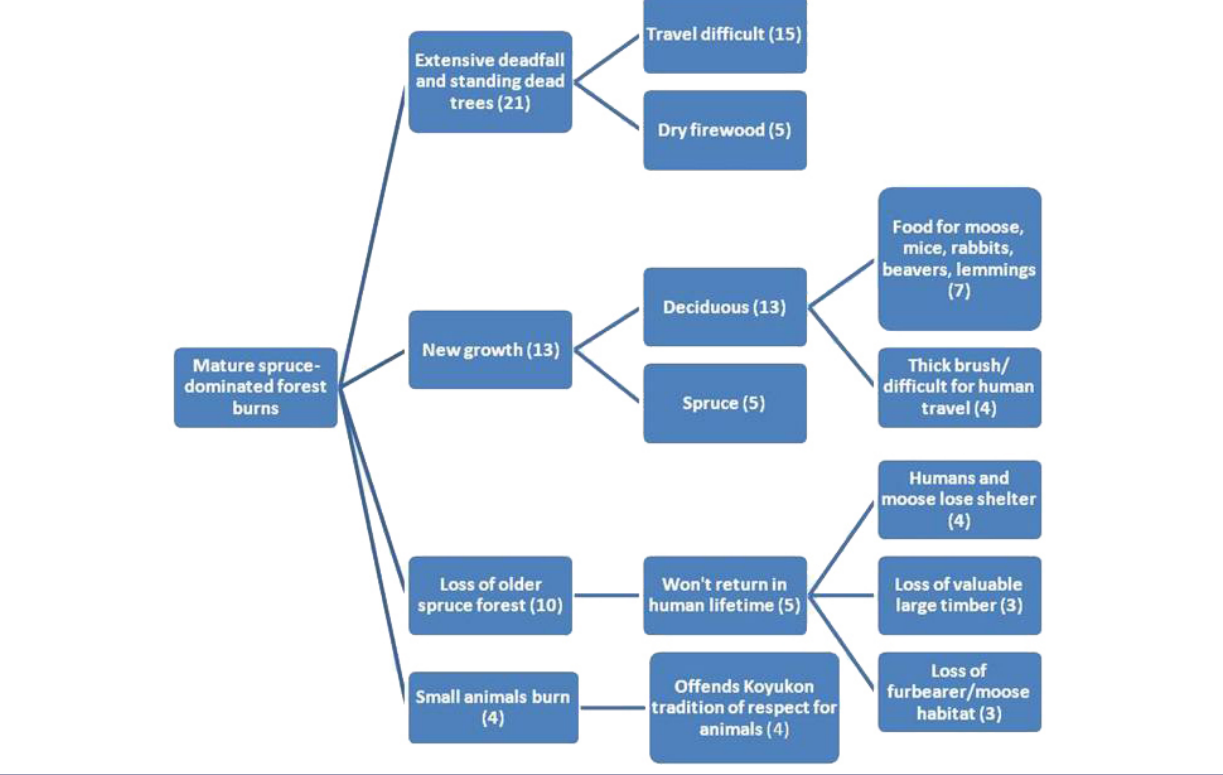
Fig. 6 . Fire effects as reported by Koyukon respondents. First column represents type of burn, second column represents primary effects, third column represents secondary effects, and fourth column represents tertiary effects. Note that the numbers in parentheses refer to the number of respondents who provided that